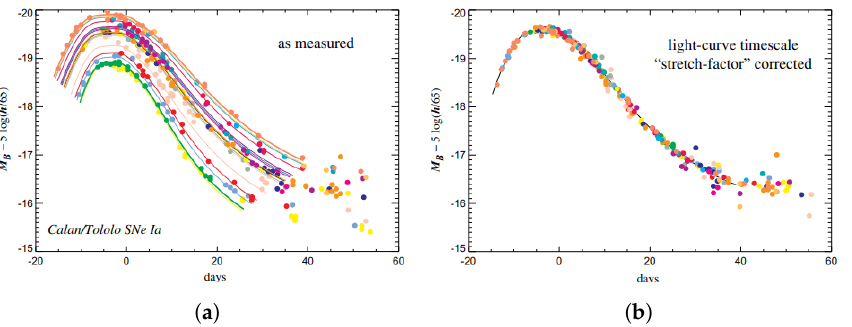
Figure 5. ( a ) Light curves of some local Type Ia supernovae as measured. ( b ) The light curves of the same supernovae corrected in terms of their width. Adapted from: